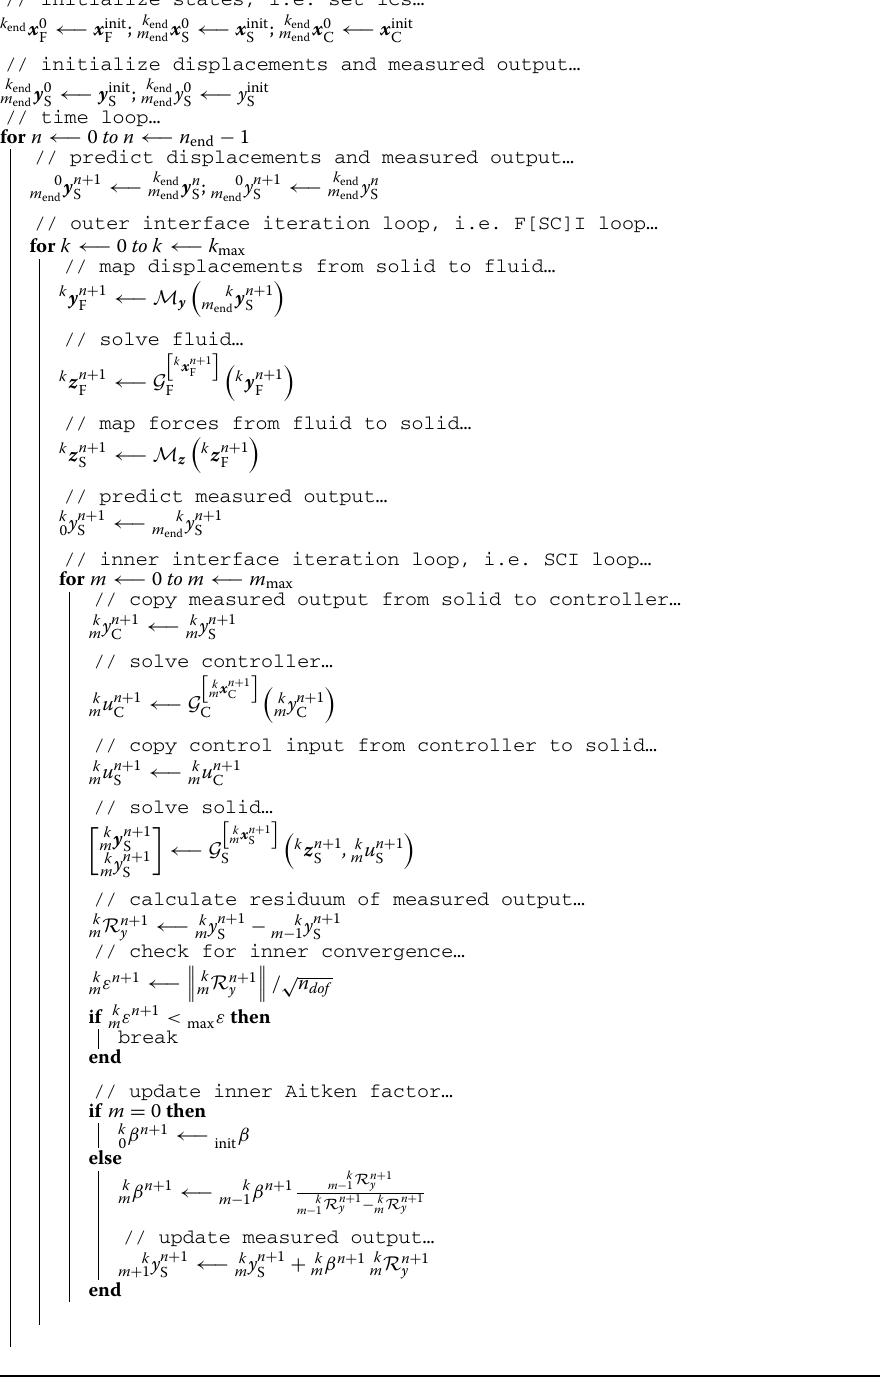
Algorithm 3: Pseudocode for the partitioned F[SC]I scheme(nested [SC]